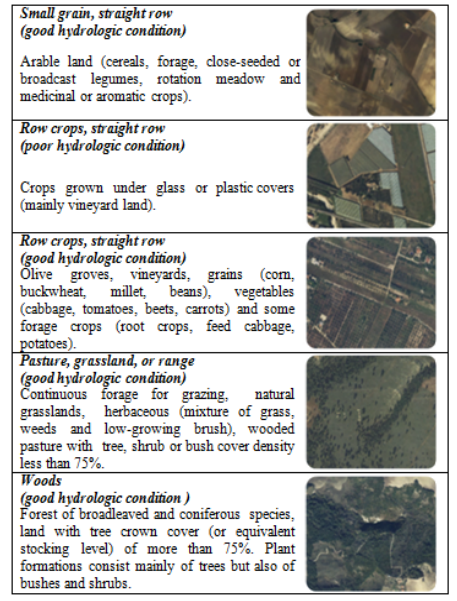
Figure 3. Agricultural land cover categories